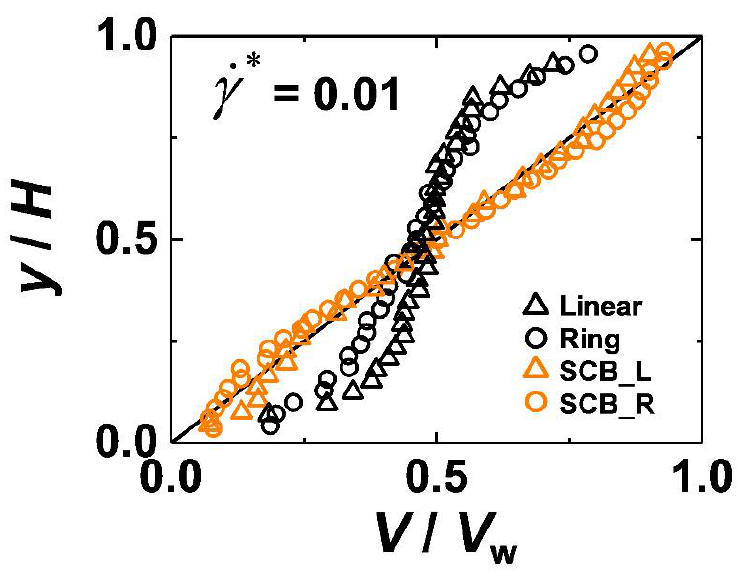
Figure 3. Streaming velocity profiles (normalized by the applied wall velocity V w ) along the velocity gradient direction at a certain intermediate shear rate for the simulated C 128 H 258 linear (black triangles), C 128 H 256 ring (black circles), C 178 H 358 SCB linear (orange triangles), and C 178 H 356 SCB ring (orange circles) PE melts. The solid line represents the ideal streaming velocity profile assuming the no-slip boundary condition.